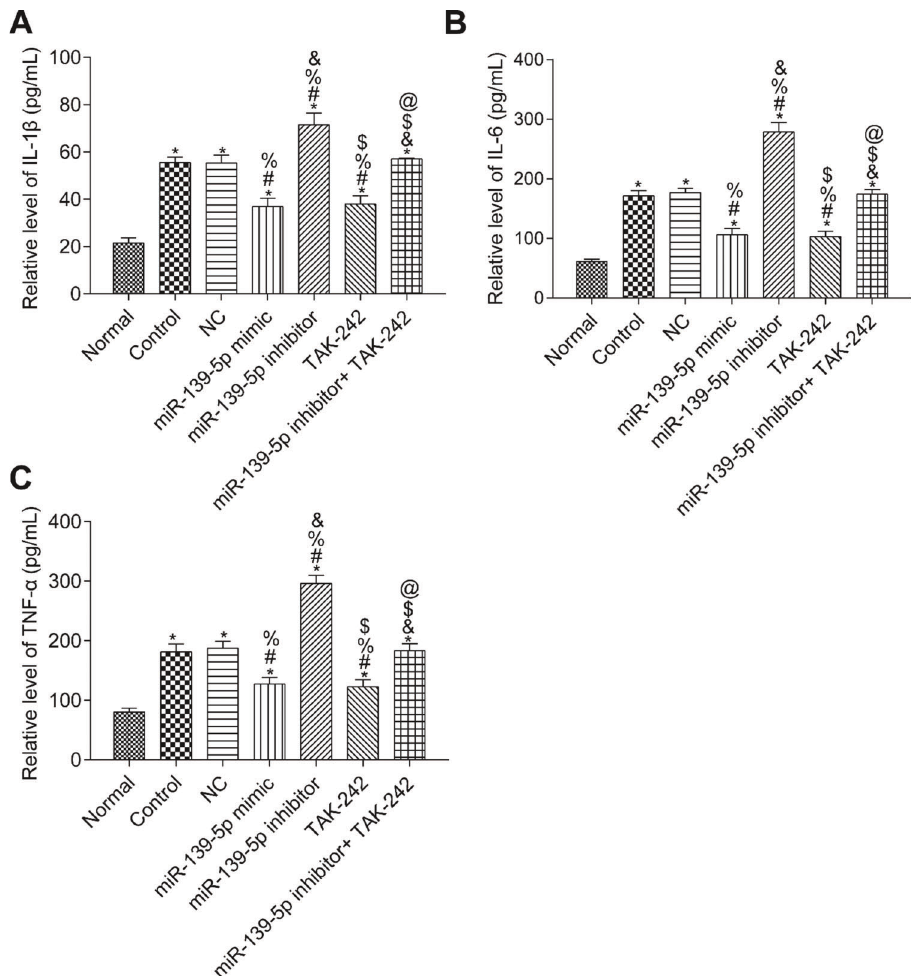
Figure 4 - Serum levels of the inflammatory factors, IL-1 b , IL-6, and TNF- a in mice of each group. IL-1 b levels (A); IL-6 levels (B); TNF- a levels (C). Significant comparisons with each group, where p o 0.05, are indicated by: ‘‘ * ’’ for the Normal group, ‘‘ # ’’ for the Control group, ‘‘ % ’’ for NC group, ‘‘ & ’’ for the miR-139-5p mimic group, ‘‘ $ ’’ for the miR-139-5p inhibitor group, and ‘‘ @ ’’ for the TAK-242